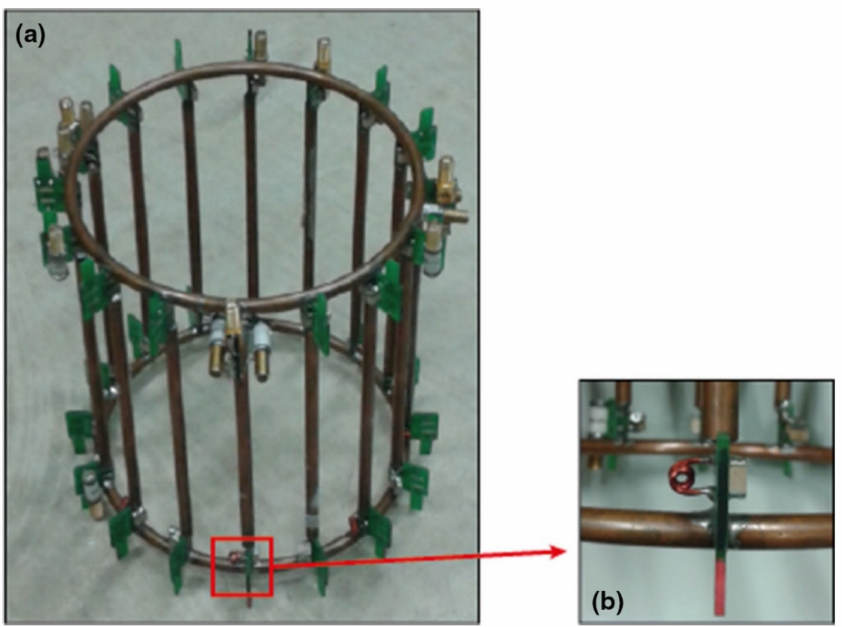
Figure 8. ( a ) The built birdcage coil; ( b ) the trap circuit. Reprinted by permission from Giovannetti et al., App Magn Reson 2015